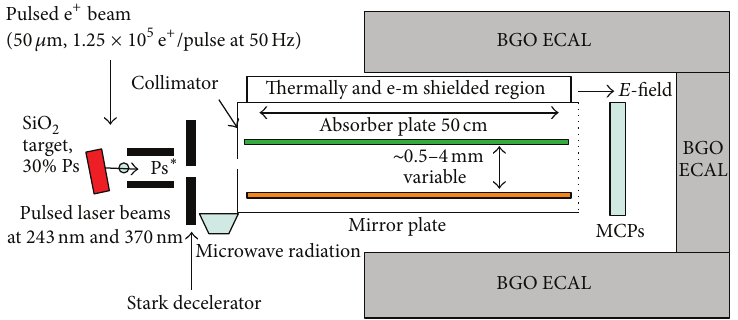
Figure 12: Possible scheme for the observation of the gravitational quantum states of